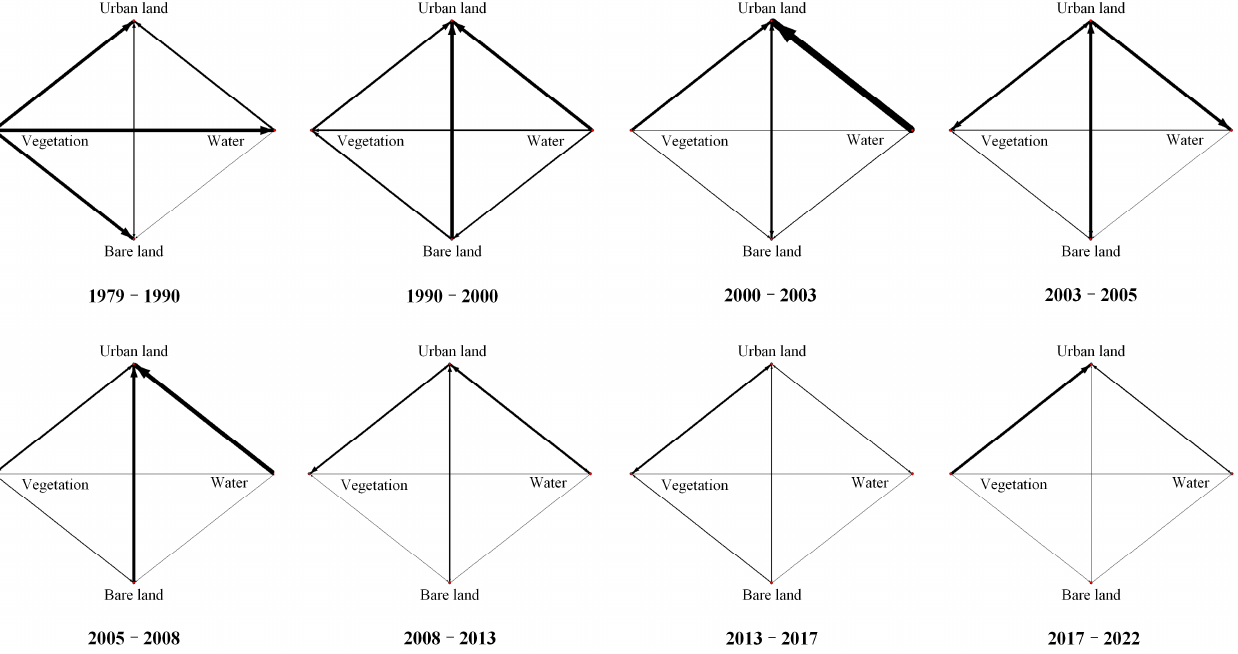
Figure 8. The relationship between transportation and urban land increase from 1979 to 2022. ( a ) The road network overlaid on the map of urban land expansion. ( b ) The transportation distance histograms for urban land increase.